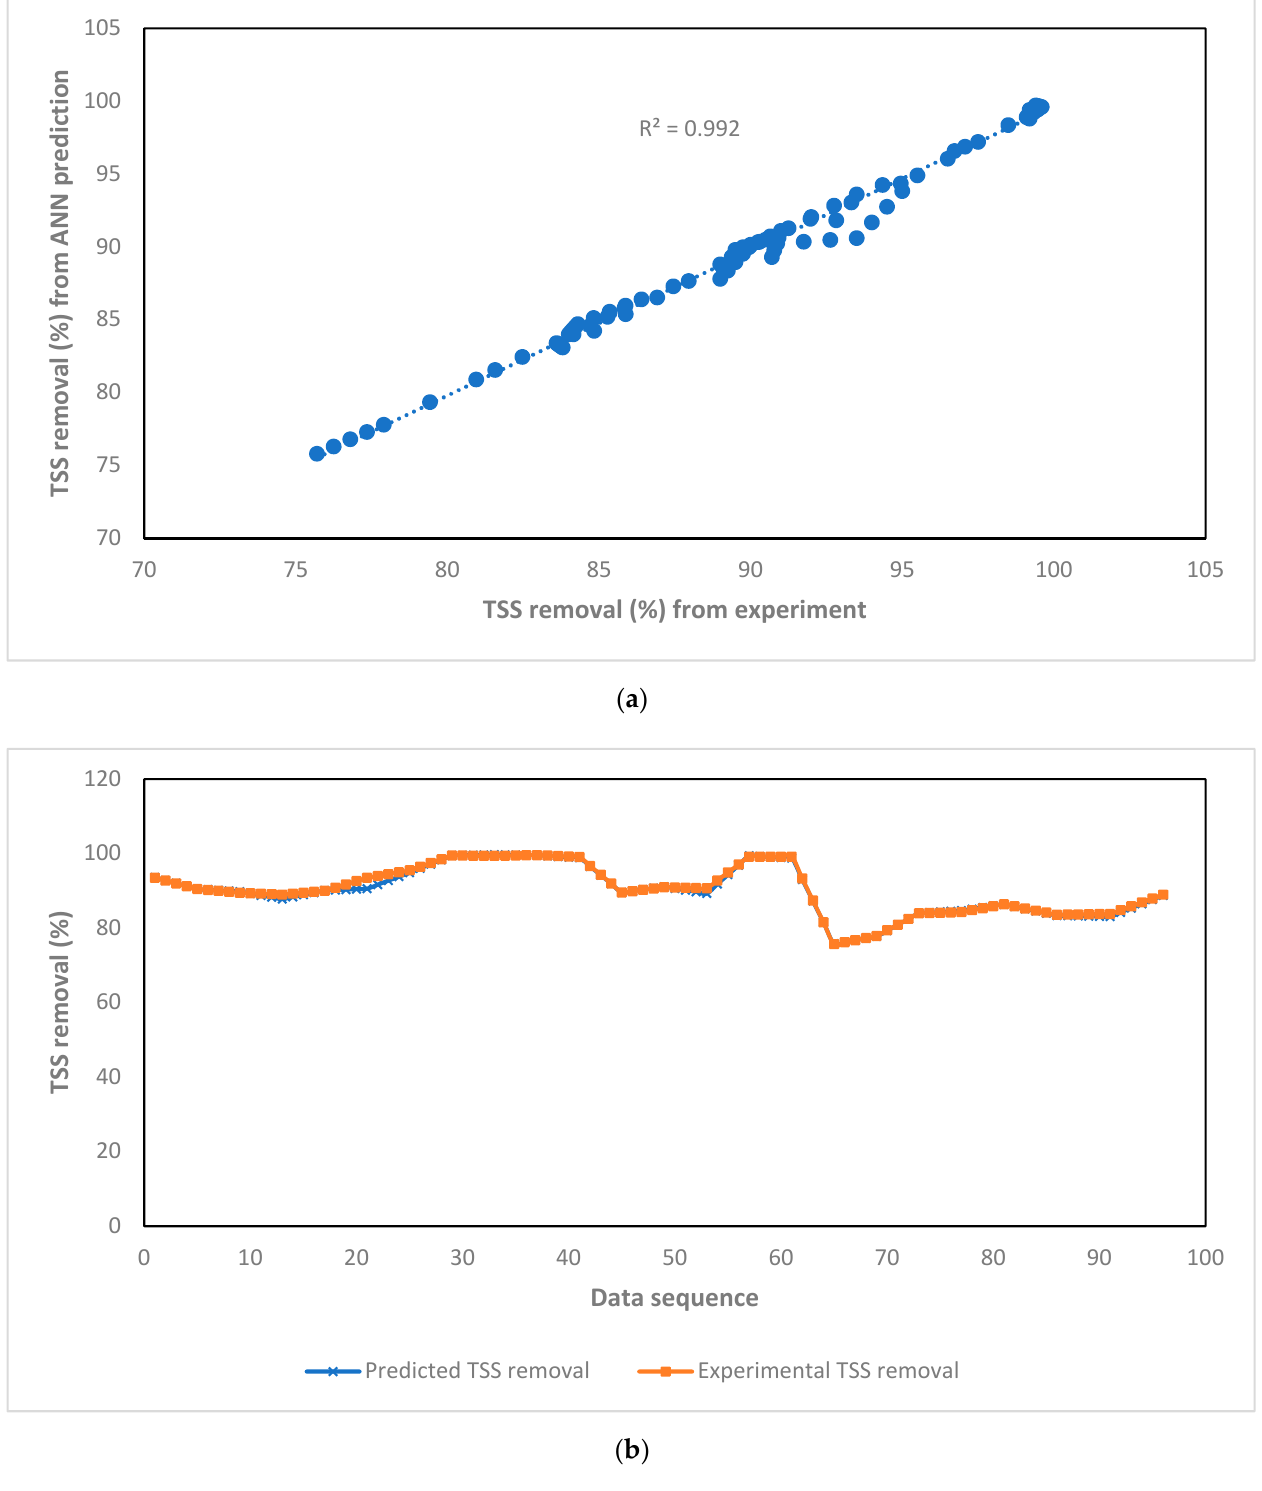
Figure 8. ( a ) Correlation between experimental data and predicted value of TSS removal. ( b ) Prediction value and measured data by ANN model for TSS removal (aerobic process).